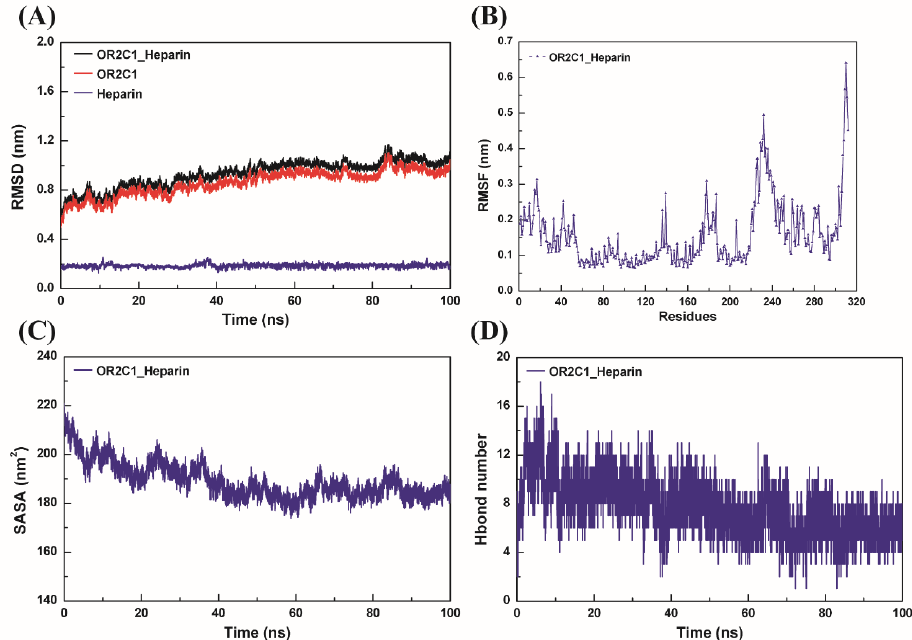
Figure 3. Molecular dynamic simulation between OR2C1 and heparin for 100 ns in central cavity. ( A ) RMSD of the residues of modelled OR2C1 structure and heparin; ( B ) RMSF of the residues in the system of OR2C1 binding heparin; ( C ) SASA; ( D ) number of H-bonding contacts with ligand.